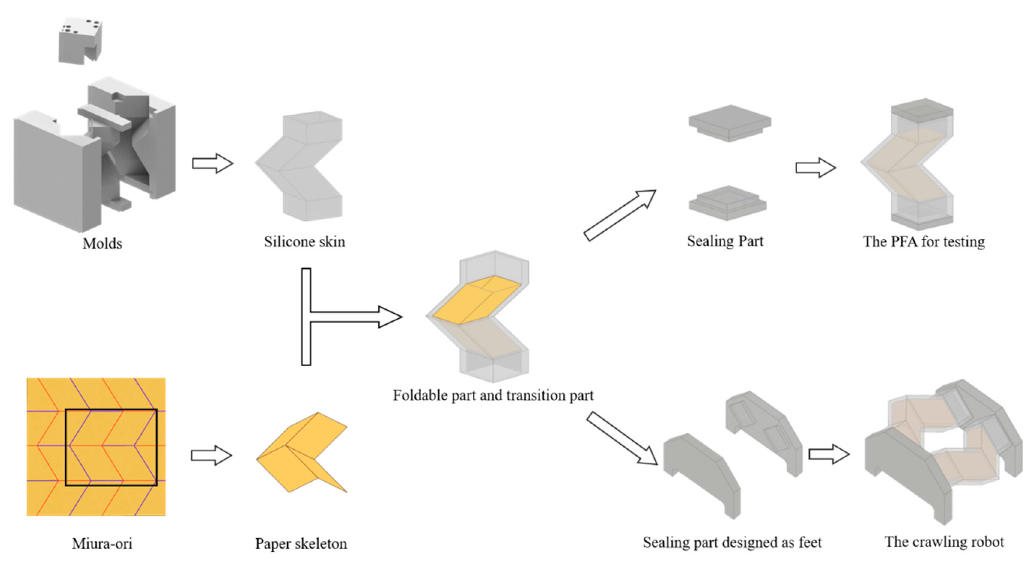
Figure 7. The fabrication processes of the PFA and the crawling robot.